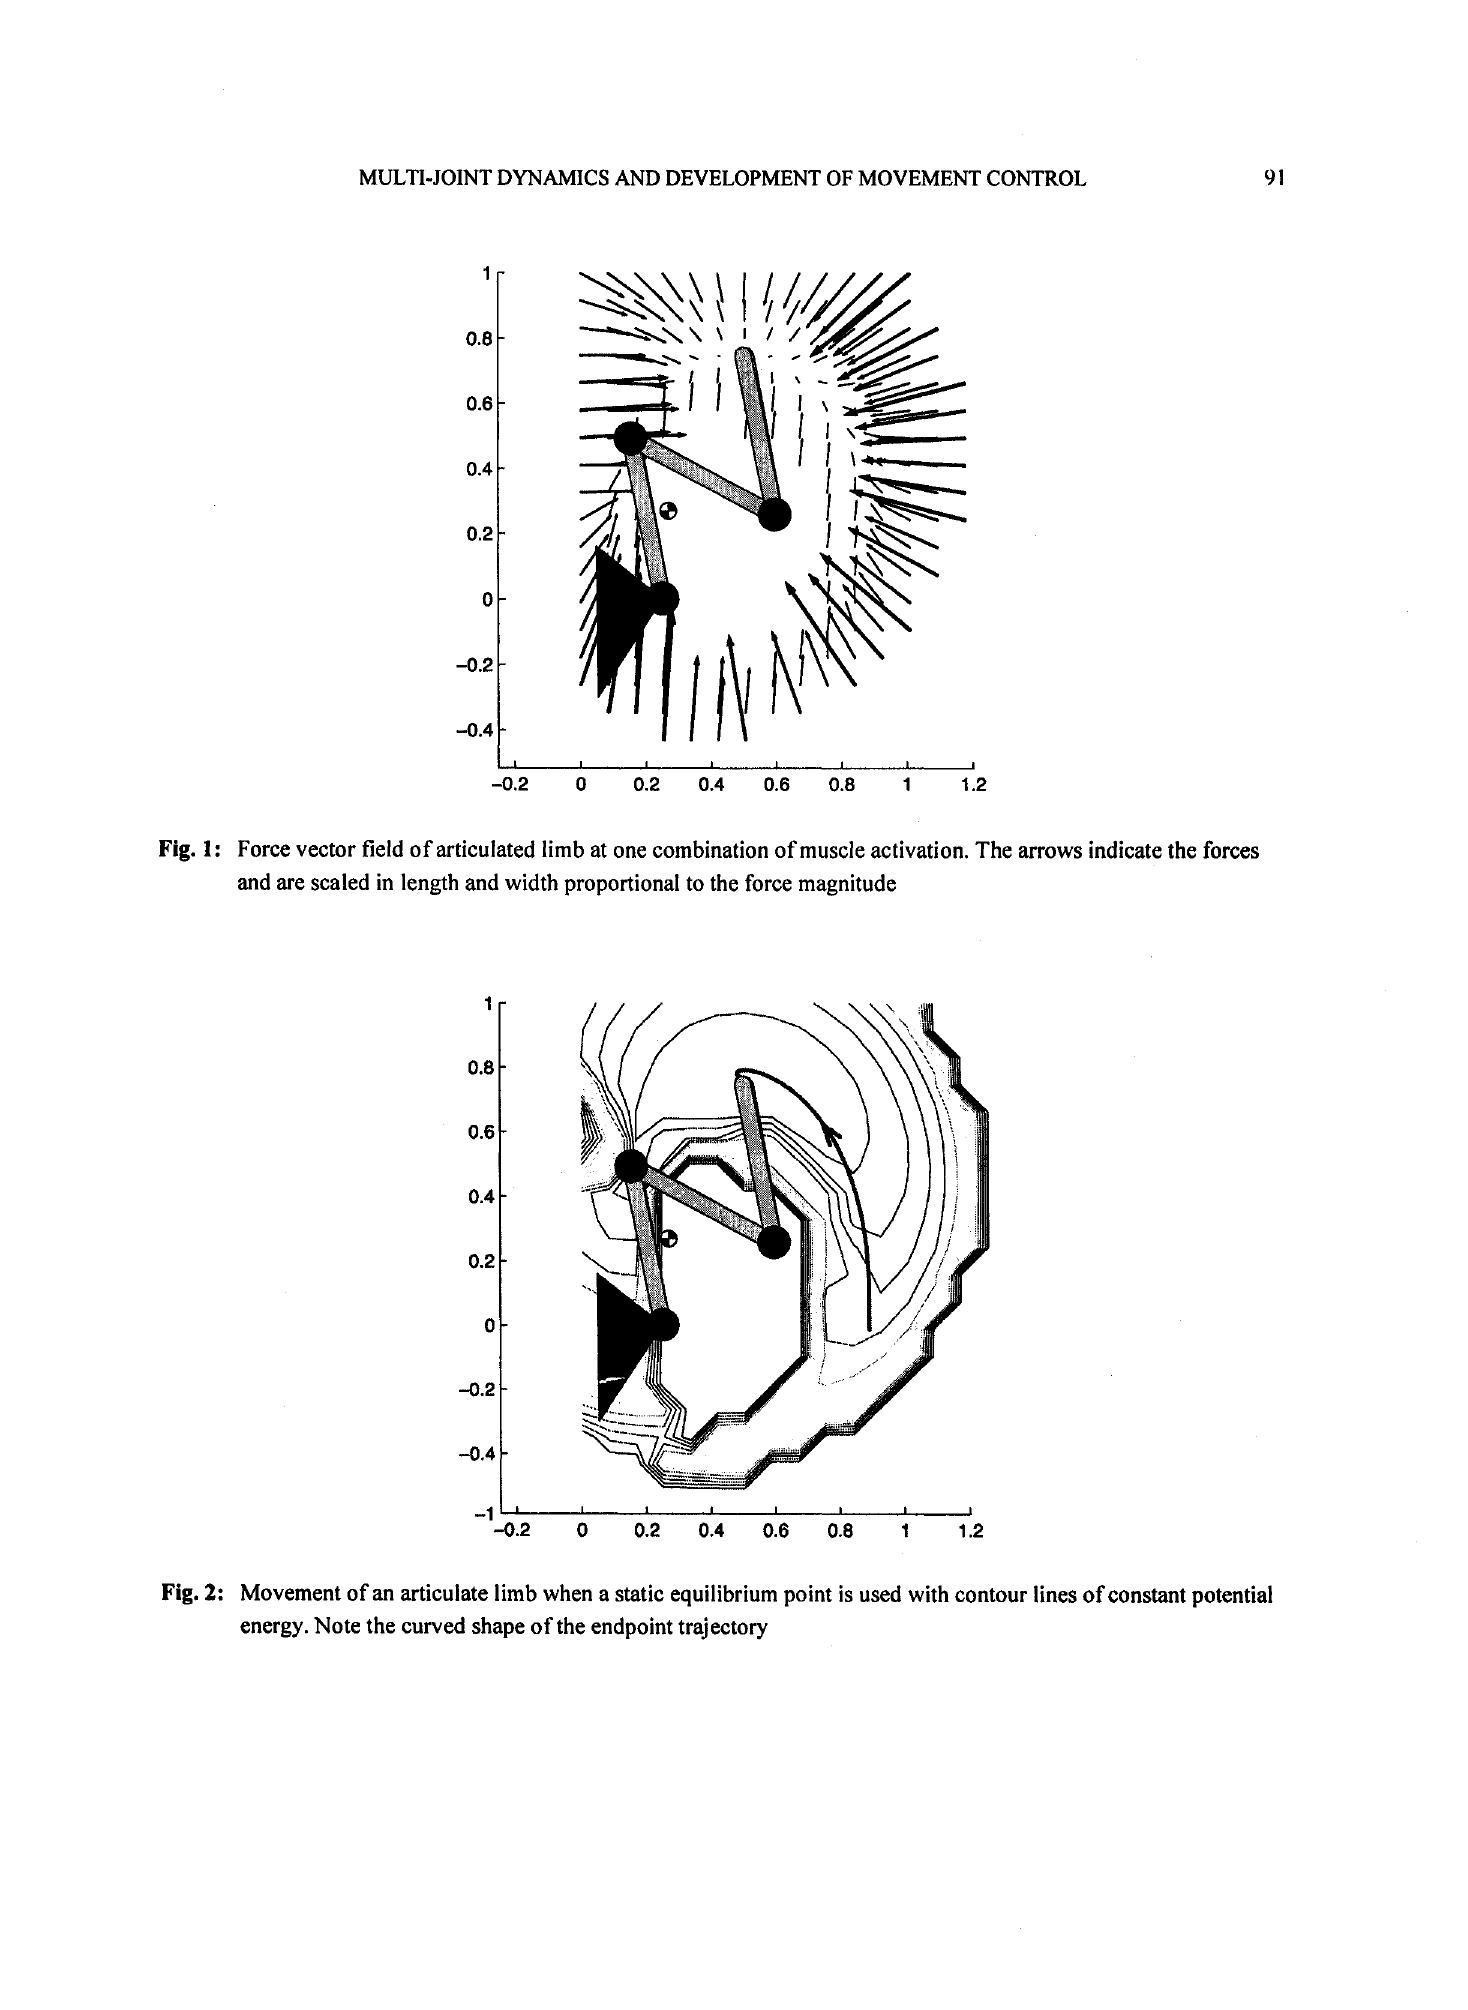
Fig. 2: Movement of an articulate limb when a static equilibrium point is used with contour lines of constant potential energy. Note the curved shape ofthe endpoint